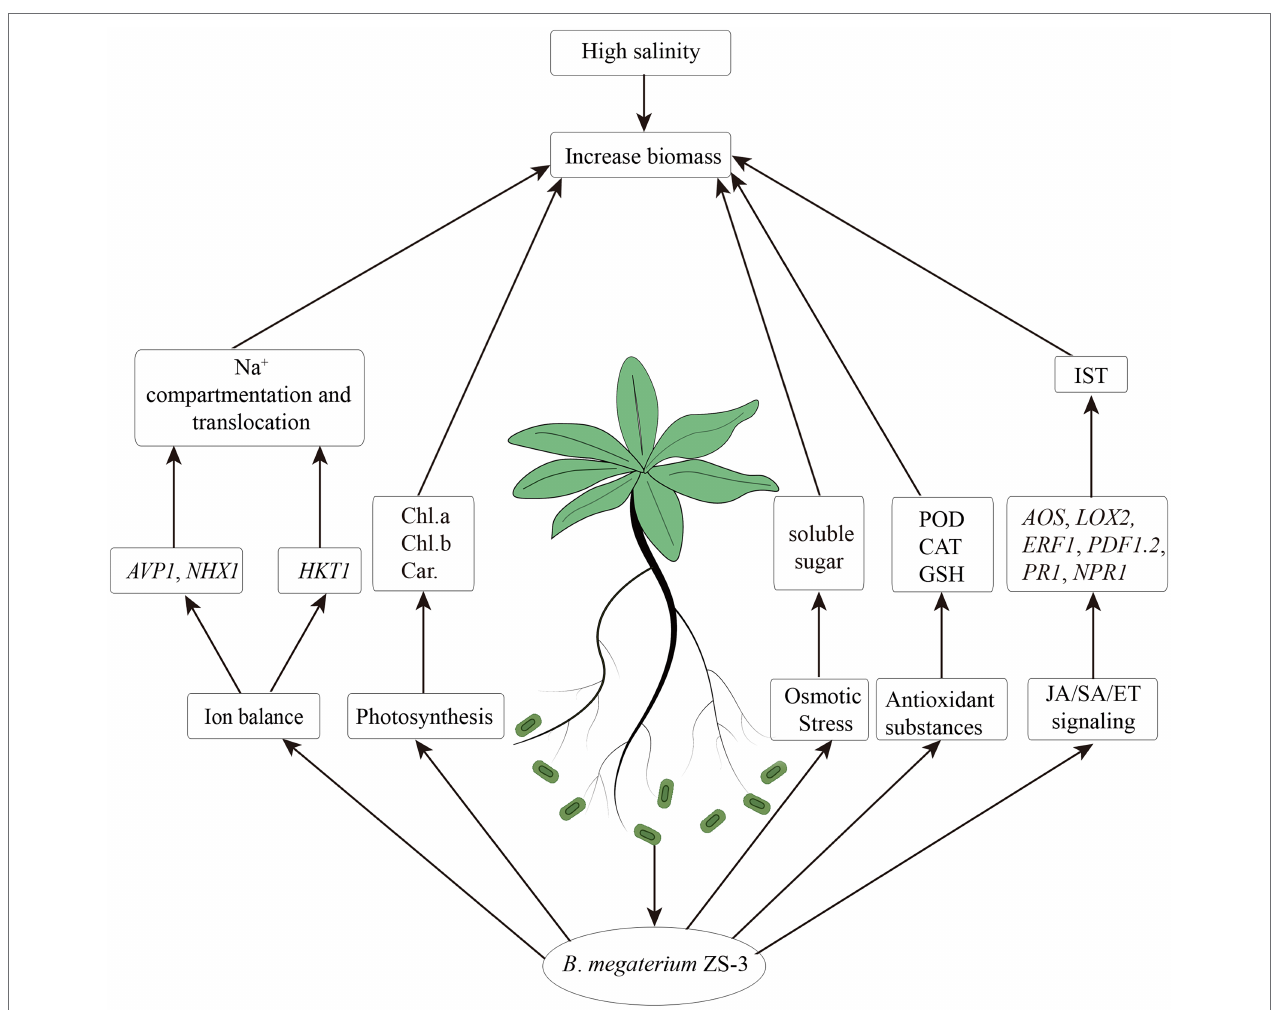
FIGURE 7 | Possible mechanisms by which Bacillus megaterium strain ZS-3 mediates salt stress tolerance in Arabidopsis thaliana under salt